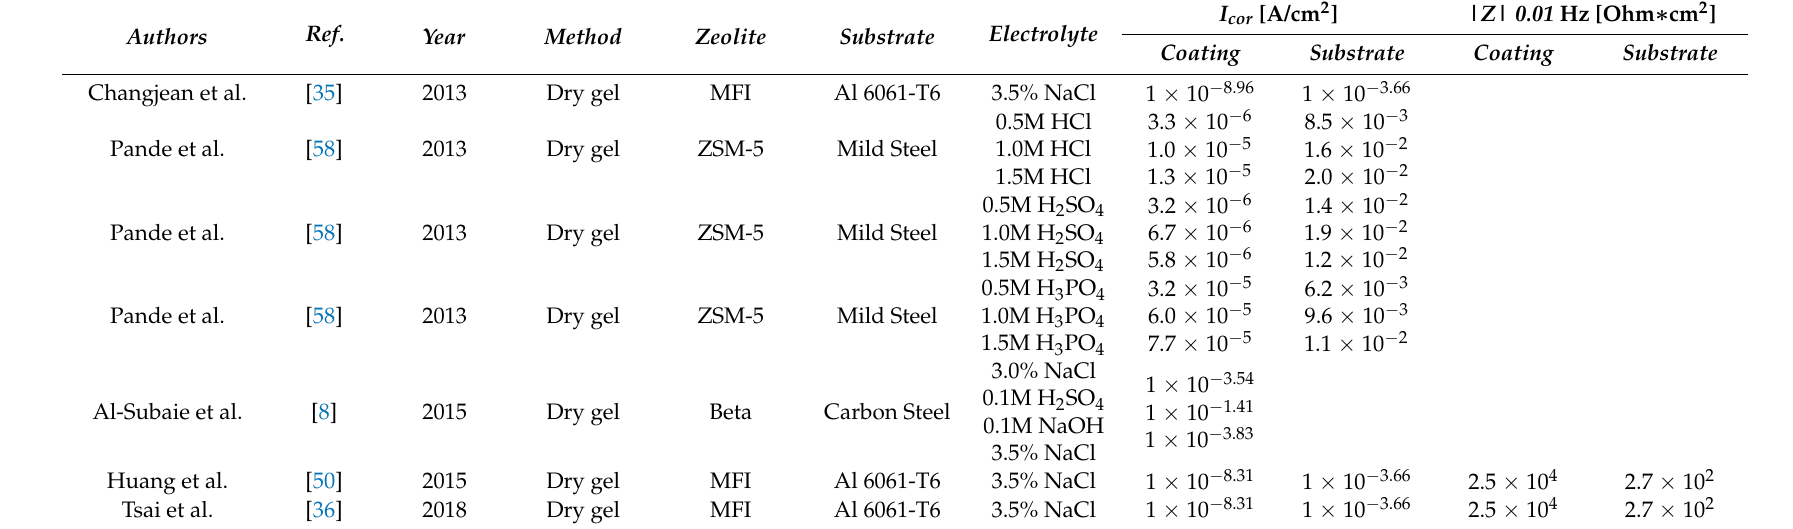
Coating Substrate